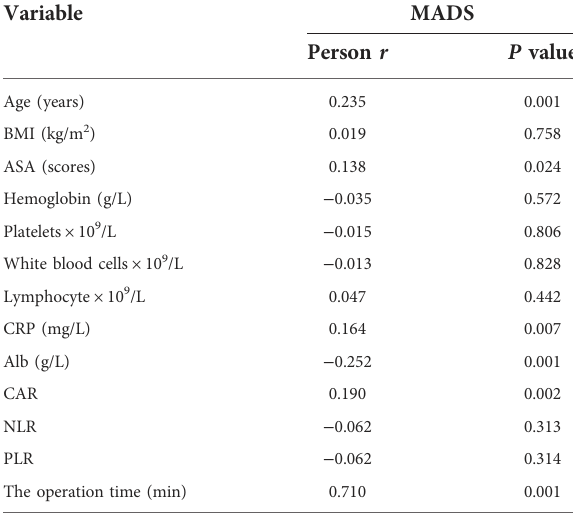
better than that of CRP (AUC: 0.761) and Alb (AUC: 0.300). Based on the ROC curve analysis, the results showed that the